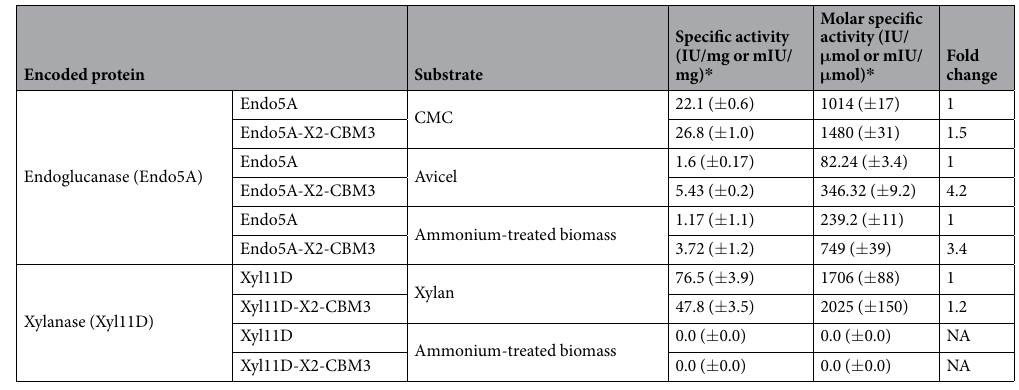
Table 4. Activities of endoglucanase Endo5A and xylanase Xyl11D fused with X2-CBM3. * Units in IU/mg or IU/ μ mol are given for amorphous substrates CMC and xylan. Units in mIU/mg or mIU/ μ mol are given for crystalline substrates Avicel and ammonium-treated